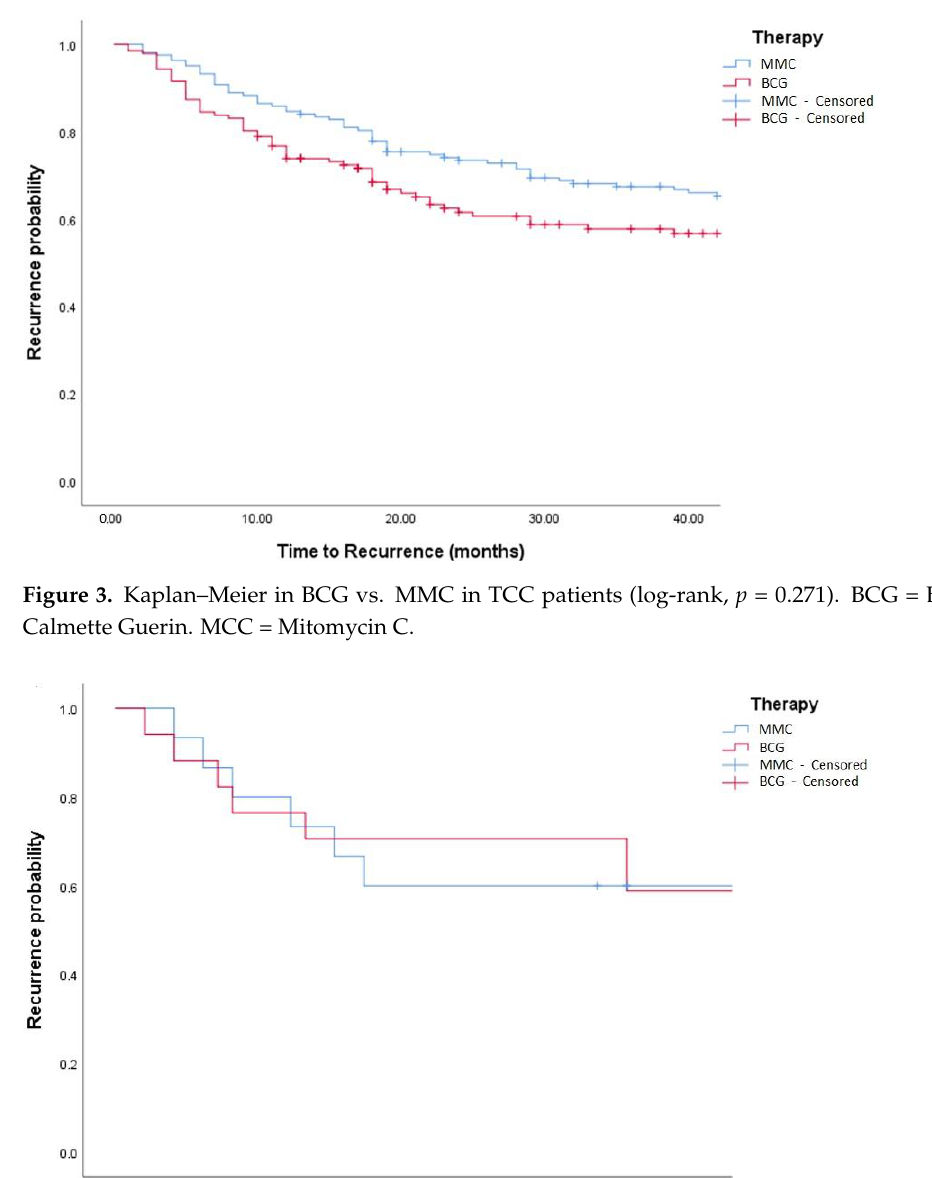
Figure 4. Kaplan – Meier in TCC+SCC patients (log-rank, p = 0.759).